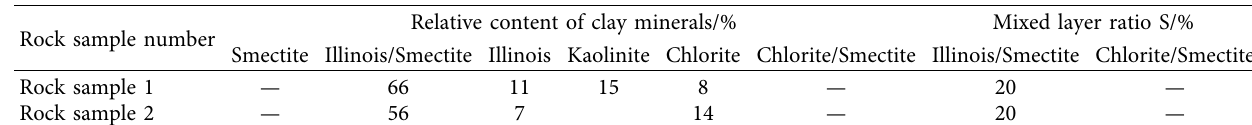
Figure 1: Layout of the mining roadway and lithology of the roof and floor. (a) Schematic diagram of intersection of mining roadway, (b) Lithology of roof and floor. Table 1: Mineral composition content of